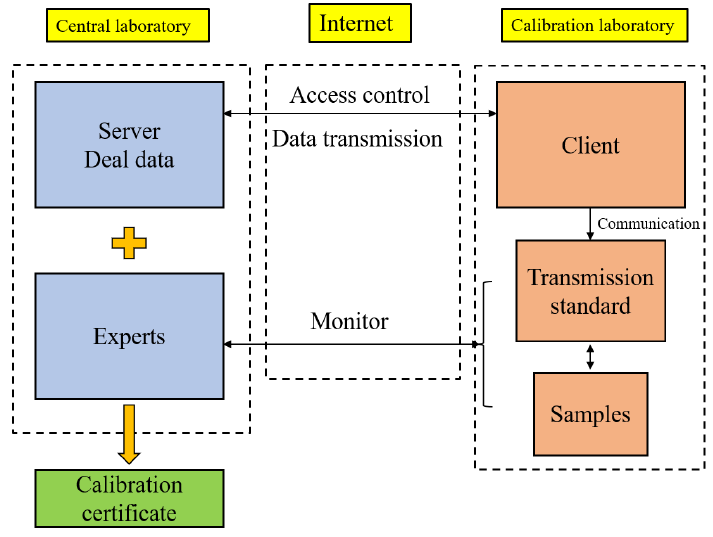
Figure 1. Remote calibration service system framework.